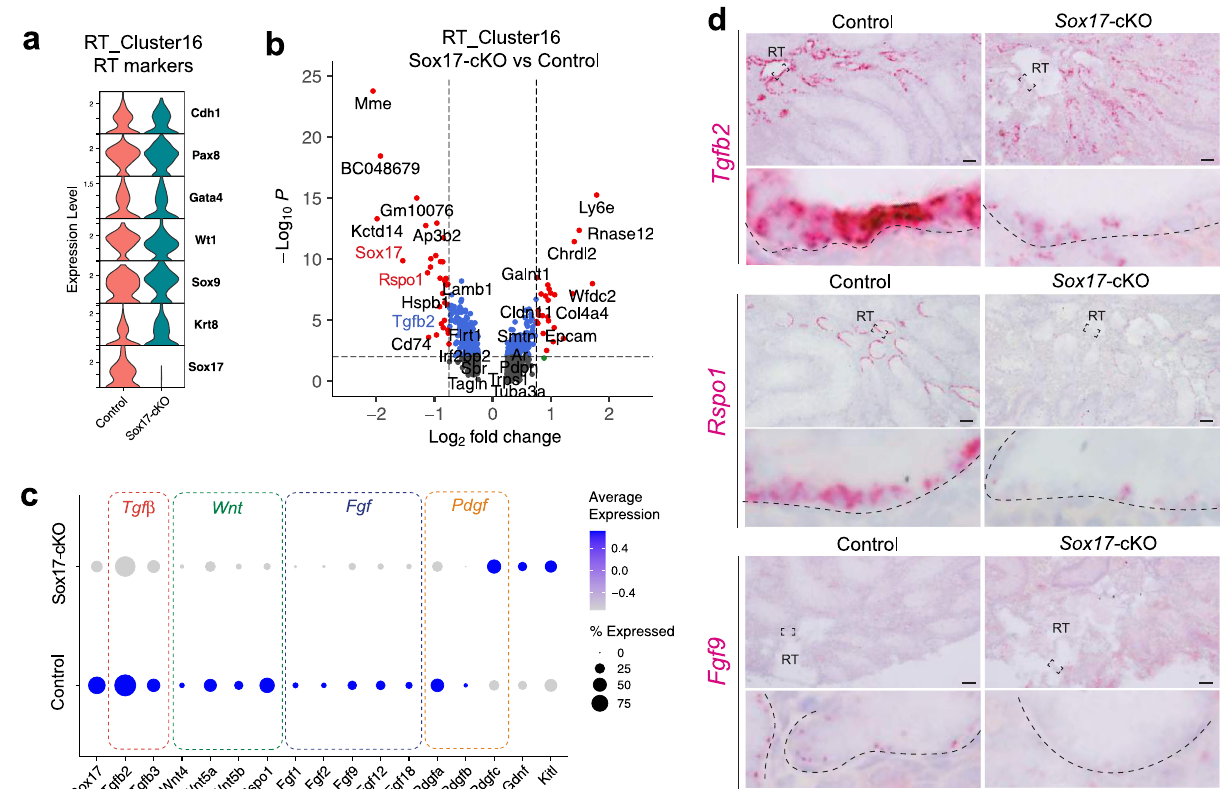
Fig.4|DecreasedexpressionofvariousgrowthfactorgenesintheRTof Sox17- cKOmice.a Violin plots showing the conservedmarker gene expression of the RT epithelialcells(cluster16)of Sox17- cKOmice. b AvolcanoplotillustratingtheDEGs of the RT between Sox17- cKO mice and the controls. c A dot plot representing the expression pro fi les of genes related to paracrine signaling in cluster 16. The expression level of several genes encoding a paracrine factor was relatively low in